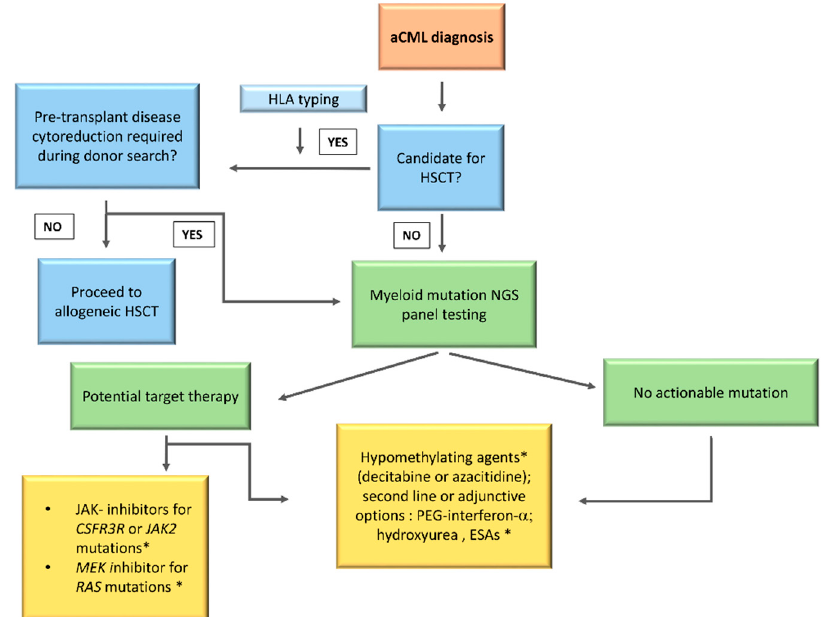
aCML. Treatment choices are made according to few key variables: eligibility for